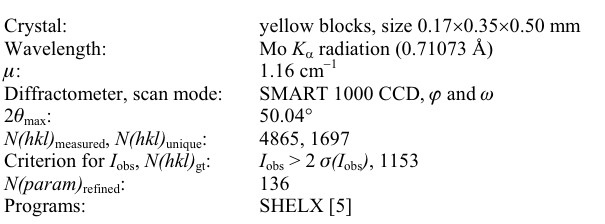
Table 1. Data collection and handling.